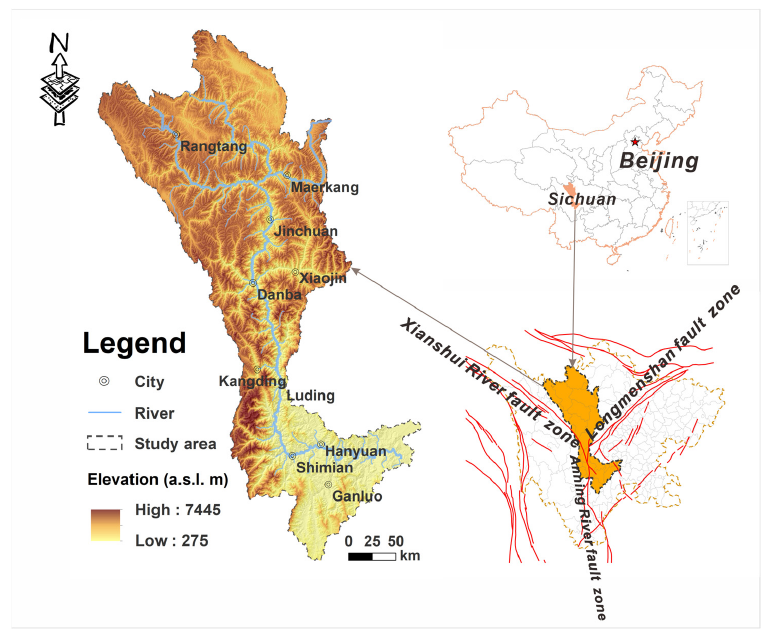
Figure 1. Location of the study area (Dadu River basin) and the distribution of faults.